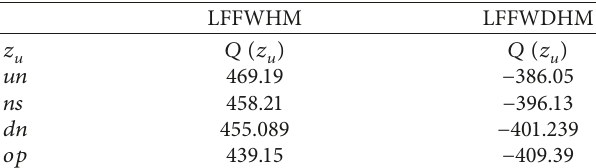
Table 8: Relative